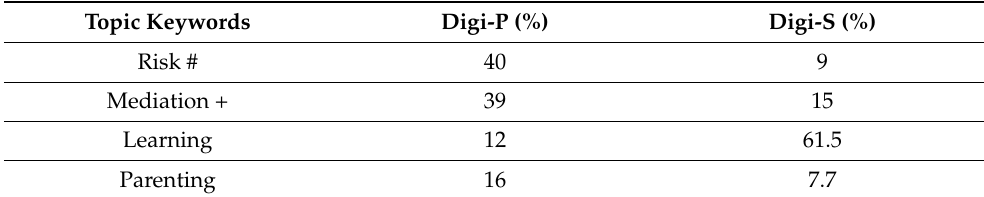
Table 1. Topics in the digital parenting and digital schooling sub-corpuses.